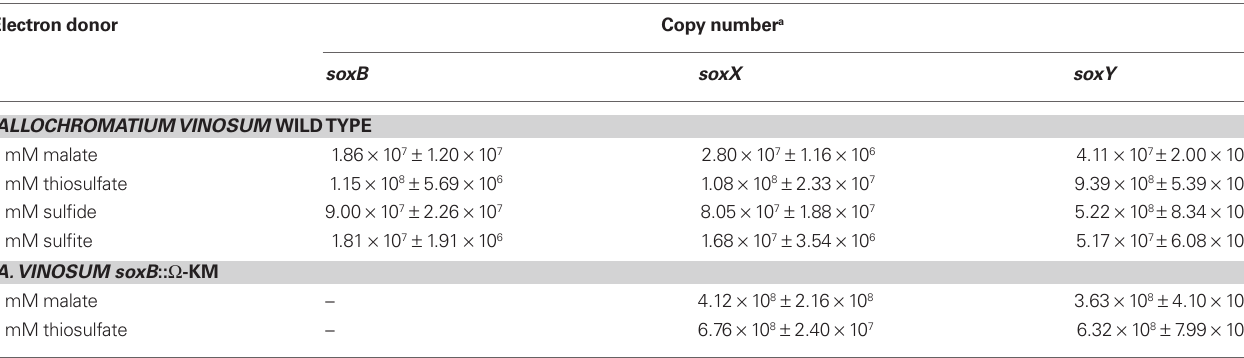
Table 3 | Expression levels of three sox genes under photoorganoheterotrophic (malate) and photolithoautotrophic (thiosulfate, sulfide, or sulfite) conditions determined by